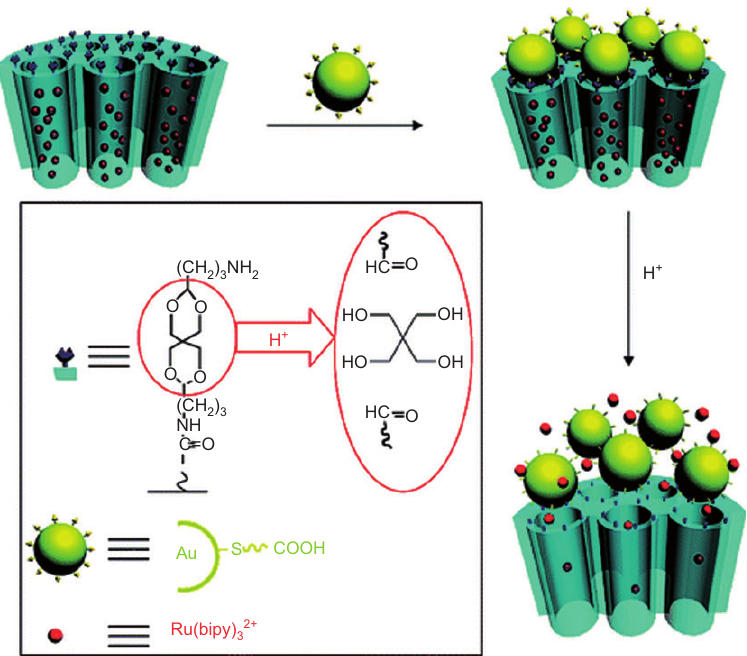
Figure 3 Schematic illustration of pH-responsive AuNP-gated MSNs [16] . Reprinted with permission from Ref. [16] . Copyright (2010) American Chemical Society.